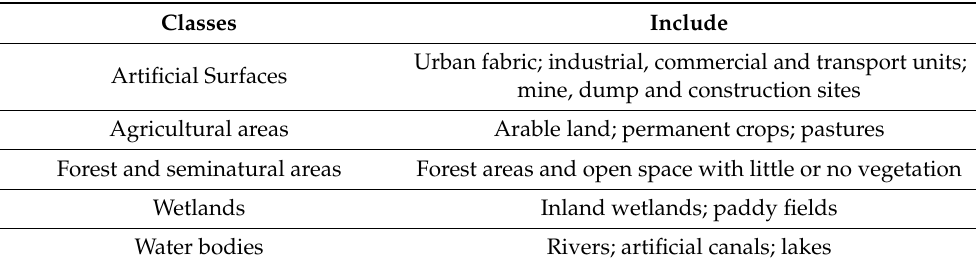
Table 1. The five categories of Land Use/Land Cover (LULC) classes used in this study. Classes Include Urban fabric; industrial, commercial and transport units; Artificial Surfaces mine, dump and construction sites Agricultural areas Arable land; permanent crops; pastures Forest and seminatural areas Forest areas and open space with little or no vegetation Wetlands Inland wetlands; paddy fields Water bodies Rivers; artificial canals;